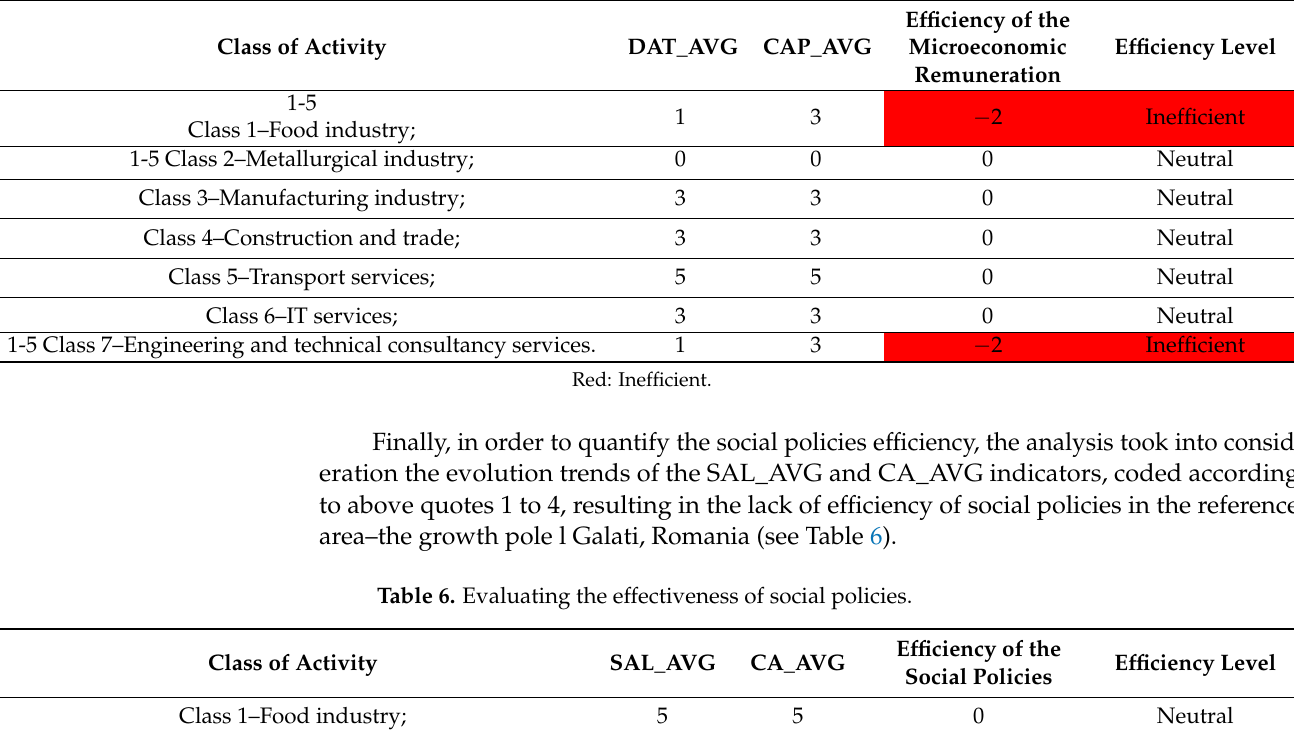
Table 5. Evaluation of the efficiency of the microeconomic remuneration in relation to the increase in the indebtedness by classes of activity.